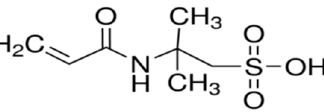
Figure 28. Chemical structure of 2-acrylamido-2-methylpropanesulfonic acid (AMPS). The best solubility and hydrophilicity when grafting methacrylamide onto polyisophthalamide (PIPAgMAA). PIPAgMAA is added to the high-performance CAUF membrane by phase inversion technology. Membrane removes arsenic from the water stream, and the separation efficiency of is related to morphology. The addition of PIPAgMAA significantly improved the hydrophilicity, structure, and performance of the membrane. PIPAgMAA is an effective CA film modifier [296].